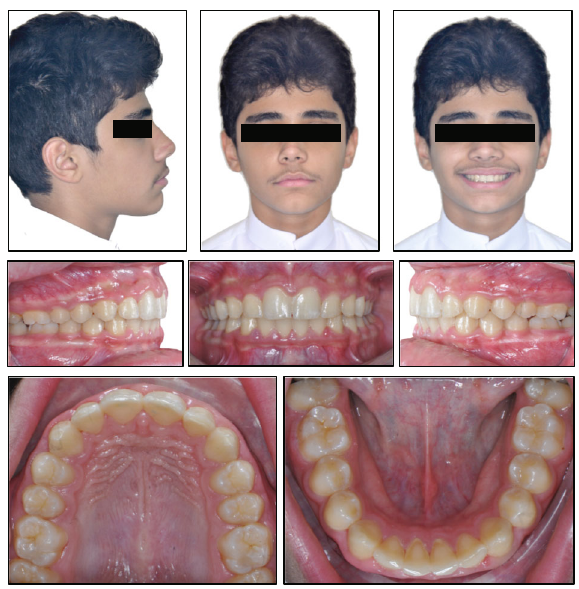
Figure 5: Posttreatment facial and intraoral photographs.